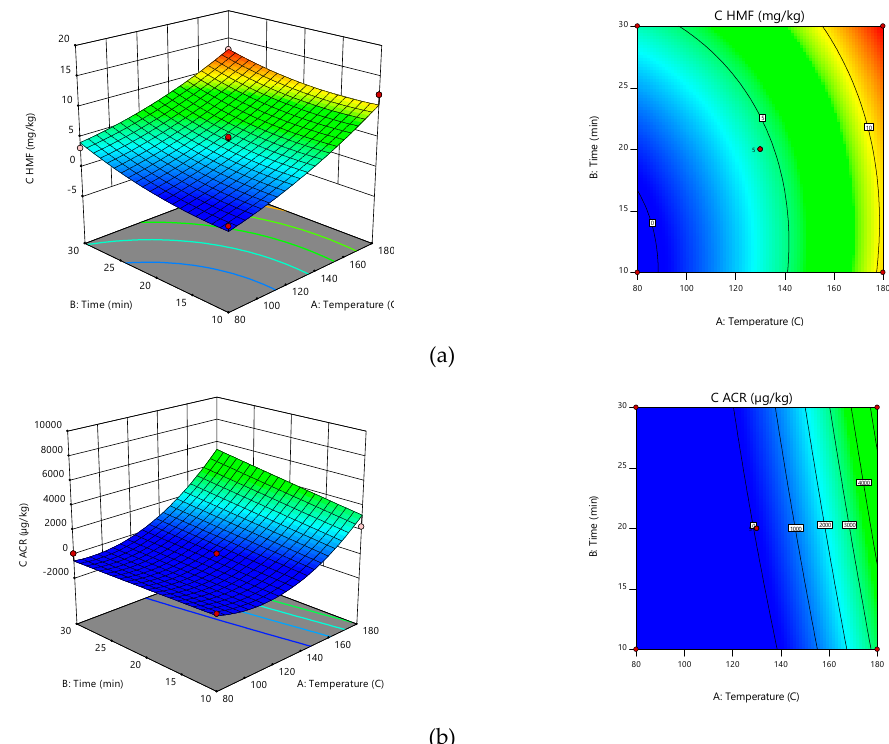
Figure 2. Response surfaces (right) and contour graphs (left) for defining the time and temperature correlative effects on the HMF ( a ) and ACR ( b ) formation.